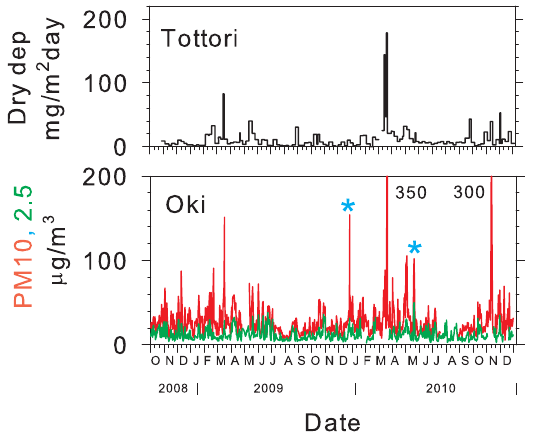
Fig. 6. Upper panel, dry deposition flux (mgm − 2 day − 1 ) of mineral dust at Tottori; lower panel, daily average concentrations of PM 10 and PM 2 . 5 at Oki Island (EANET). Blue asterisks denote days of high PM 10 concentrations but with low dry deposition flux.